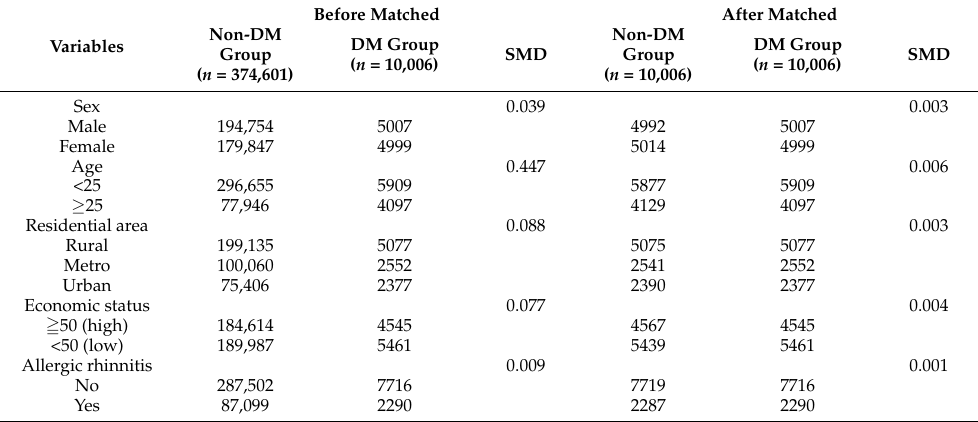
Table 1. Characteristics of the control (non-DM) and study (DM)